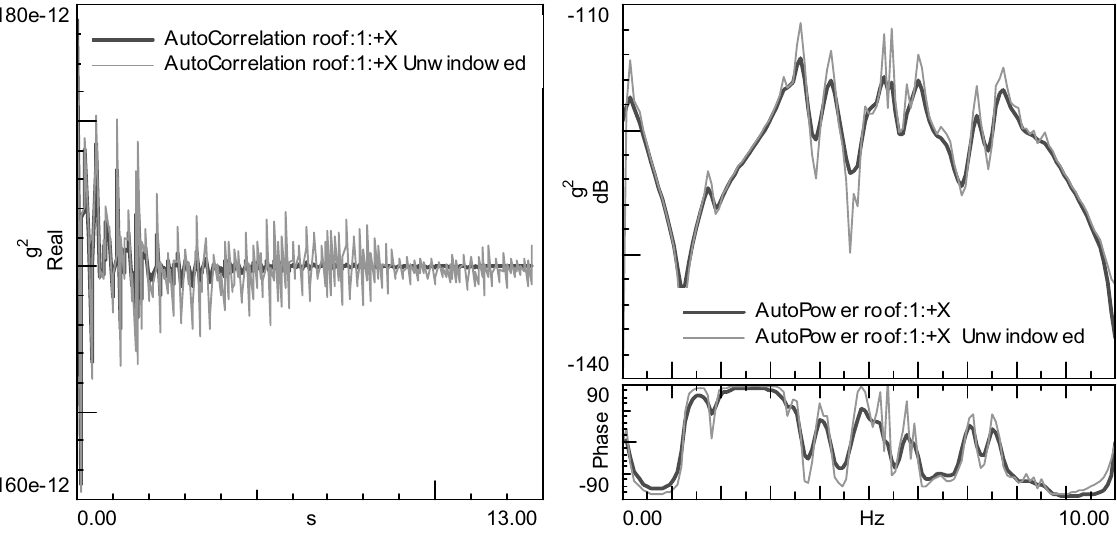
Fig. 3. (Left) Typical output correlation; before and after applying an exponential window. (Right) Corresponding half